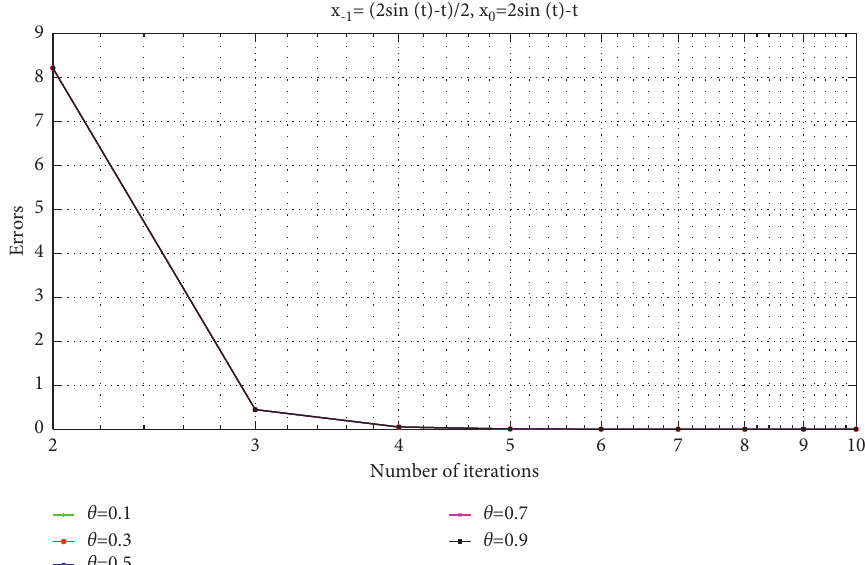
Figure 5: The Cauchy error plotting number of iterations for different parameters θ .